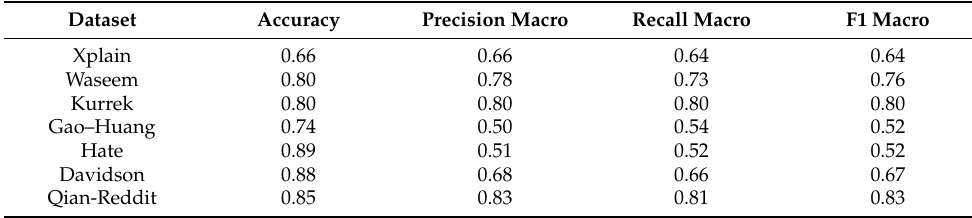
Table A2. Scores obtained on the benchmark Datasets using the SVM algorithm. Dataset